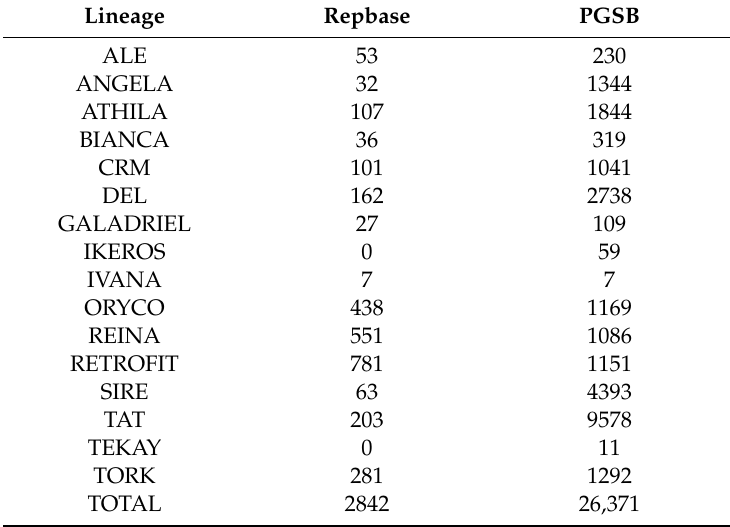
Table 6. Number of nucleotide sequences of each plant lineage used in Repbase and PGSB databases.